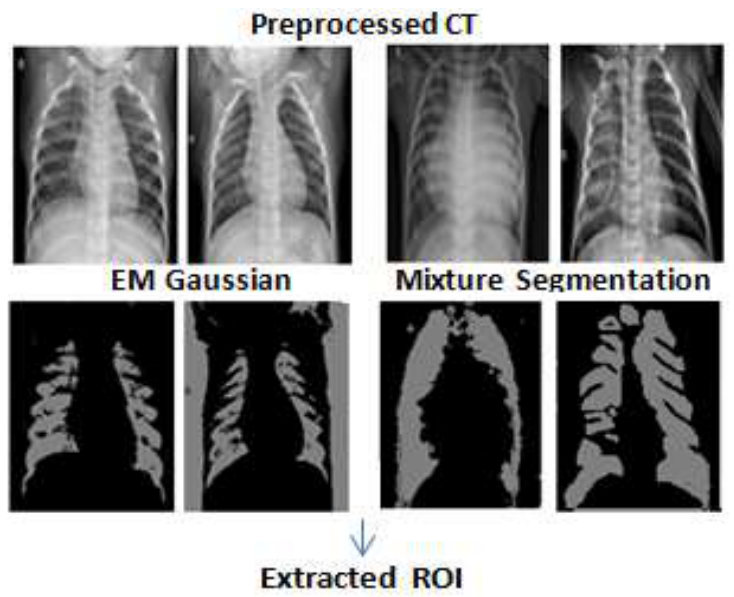
Figure 6. Examples of the resulting EMGMM segments for extracting ROI.